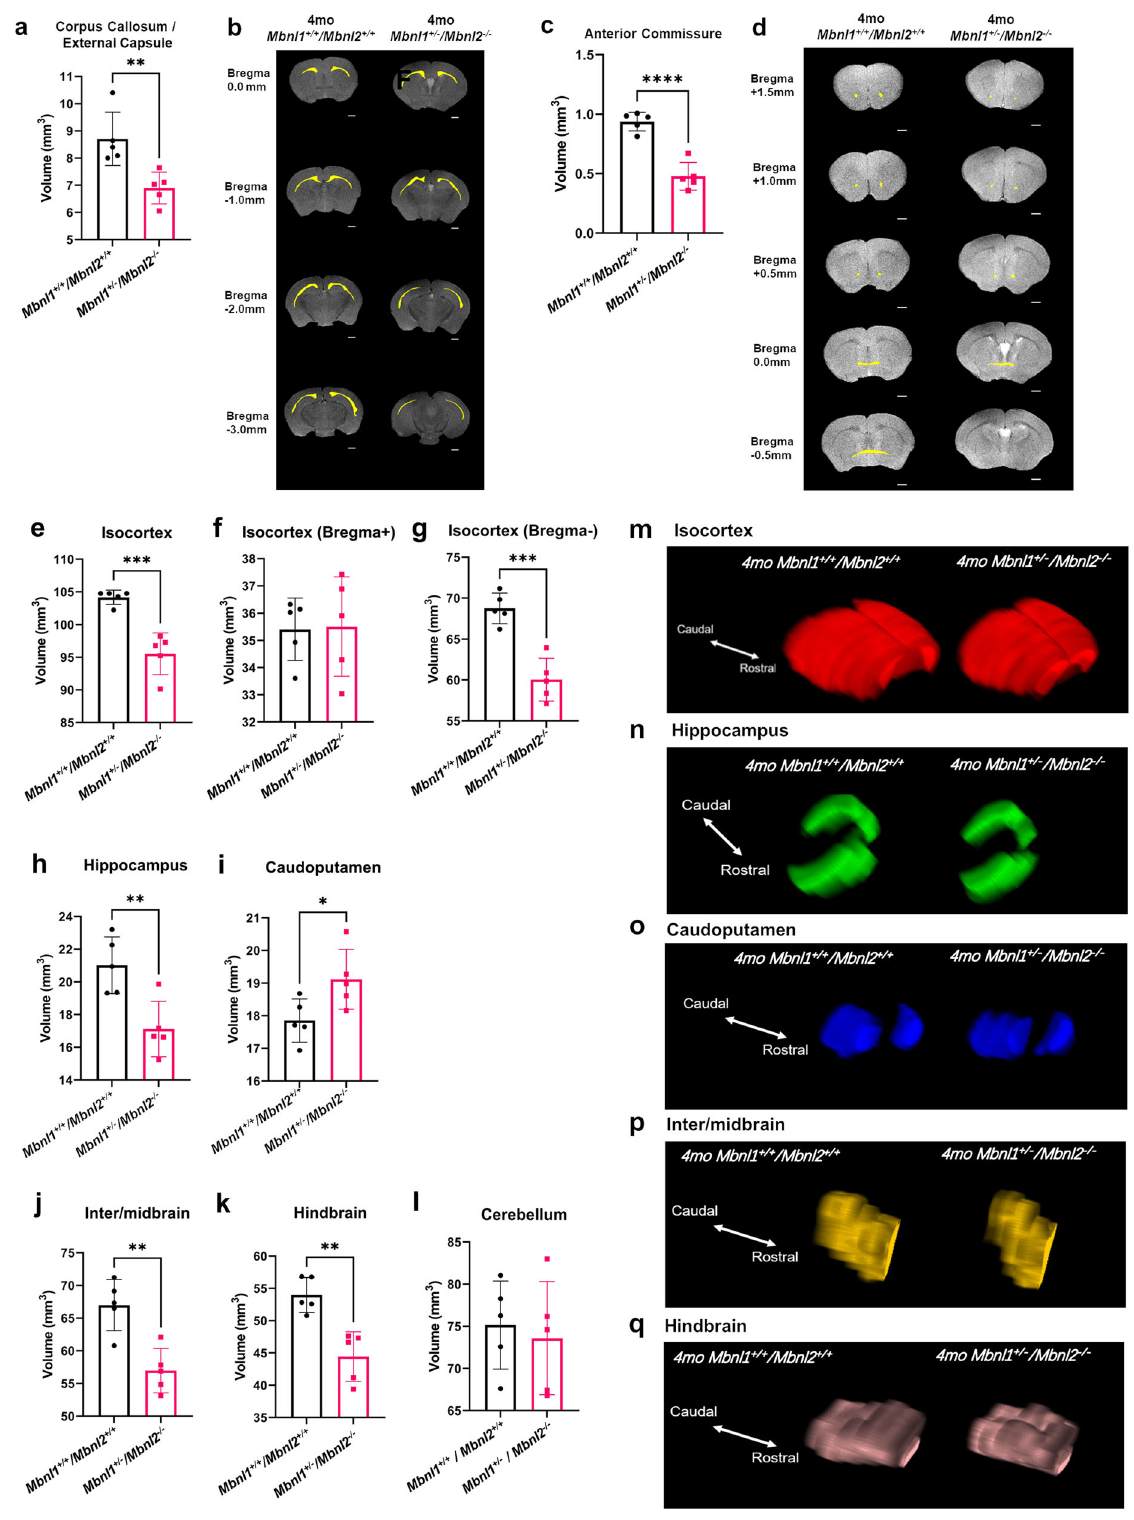
Fig. 3 White- and gray matter regional volume changes in 4mo Mbnl1 + / − /Mbnl2 − / − mice. a Corpus callosum/external capsule measurements (mean ± SD) are shown. b Representative axial brain slices from FSE T2w MRI scans with corpus callosum/external capsule volumes overlaid in yellow. c Anterior commissure measurements (mean ± SD) are shown. d Representative axial brain slices from FSE T2w MRI scans with anterior commissure volumes overlaid in yellow. Scale bar in 2D axial images denotes 1 mm. e – l Isocortex, isocortex (Bregma + ), isocortex (Bregma − ), hippocampus, caudoputamen, inter-/midbrain, hindbrain, and cerebellum volume measurements (mean ± SD) are shown. m – q 3D caudal – rostral projections of representative isocortex, hippocampus, caudoputamen, inter-/midbrain, and hindbrain regions are shown. Error bars are standard deviations (SD). In all cases, * p < 0.05, ** p < 0.01, *** p < 0.001, and **** p <